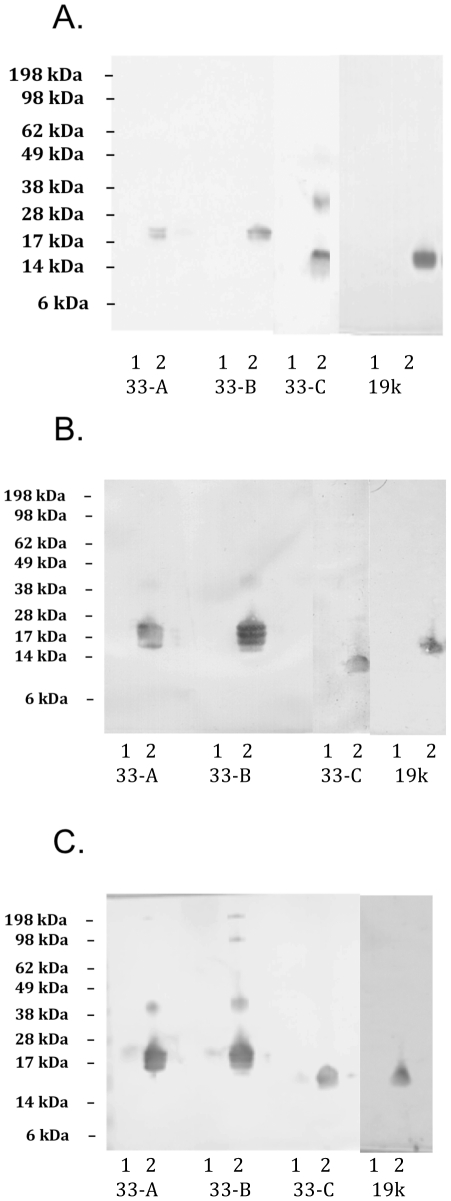
Truncated MSP1-42 proteins possess disulfide sensitive conformation.Immunoblots of recombinant proteins separated under reducing (lanes 1) and non-reducing (lanes 2) conditions and probed with conformational sensitive anti-MSP1-19 monoclonal antibodies. Panel A: Construct 33-A – 33-C and MSP1-19 probed with mAb 12.8; Panel B: Constructs 33-A – 33-C and MSP1-19 probed with mAb 2.2; and Panel C: Constructs 33-A – 33-C and MSP1-19 probed with mAb 5.2 [47], [48].